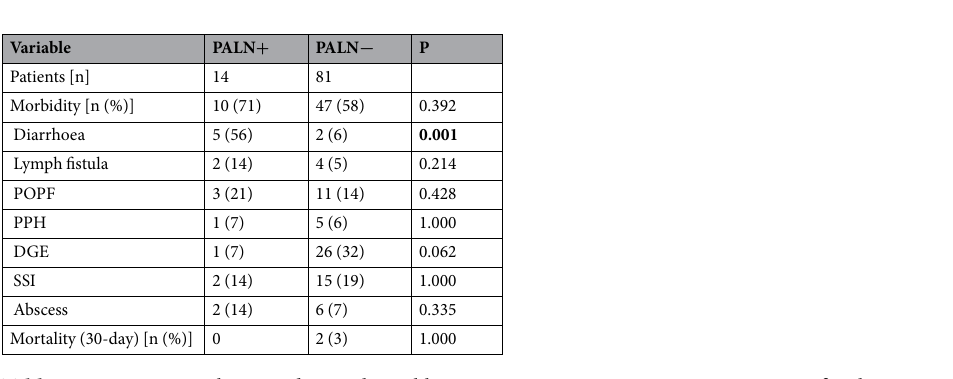
Table 3. Operative morbitity and mortality. Abbreviations: POPF, postoperative pancreatic fistulae B/C (classified according to the ISGPS definition from 2005); PPH, postpancreatectomy haemorrhage